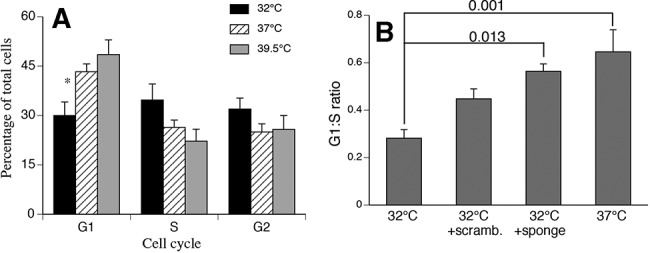
Effect of incubation temperature on cell-cycle progression. (A) Human SAECs were serum-starved for 24 h at 37°C, then incubated at 32°C, 37°C, or 39.5°C for an additional 24 h in serum-containing growth medium, stained with propidium iodide, and the proportion of cells in G1, S, and G2 phases was determined using flow cytometry. (B) HEK 293T cells were transfected with a combination of synthetic miRNA inhibitors for hsa-miR-27b-5p, hsa-miR-1260a, and hsa-miR-92a-1-5p or an equal concentration of non-targeting scrambled control inhibitor. After 24 h recovery, the cells were serum-starved for 24 h at 37°C, then incubated in serum-containing growth medium at 32°C or 37°C for 24 h, and cell-cycle analysis performed and the G1:S ratio calculated. Mean ± SEM, n = 5, (*) P < 0.05 in A. P-values are indicated in B.